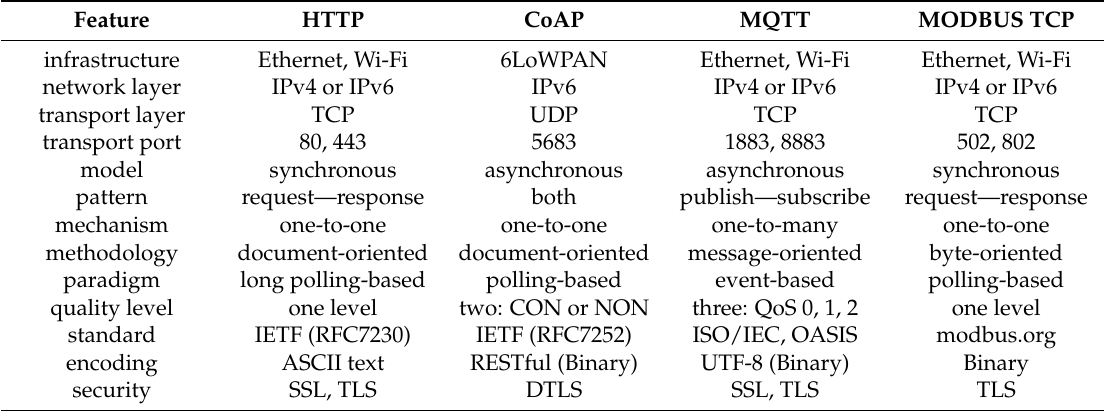
Table 2. Comparison of Internet of Things (IoT) protocols.